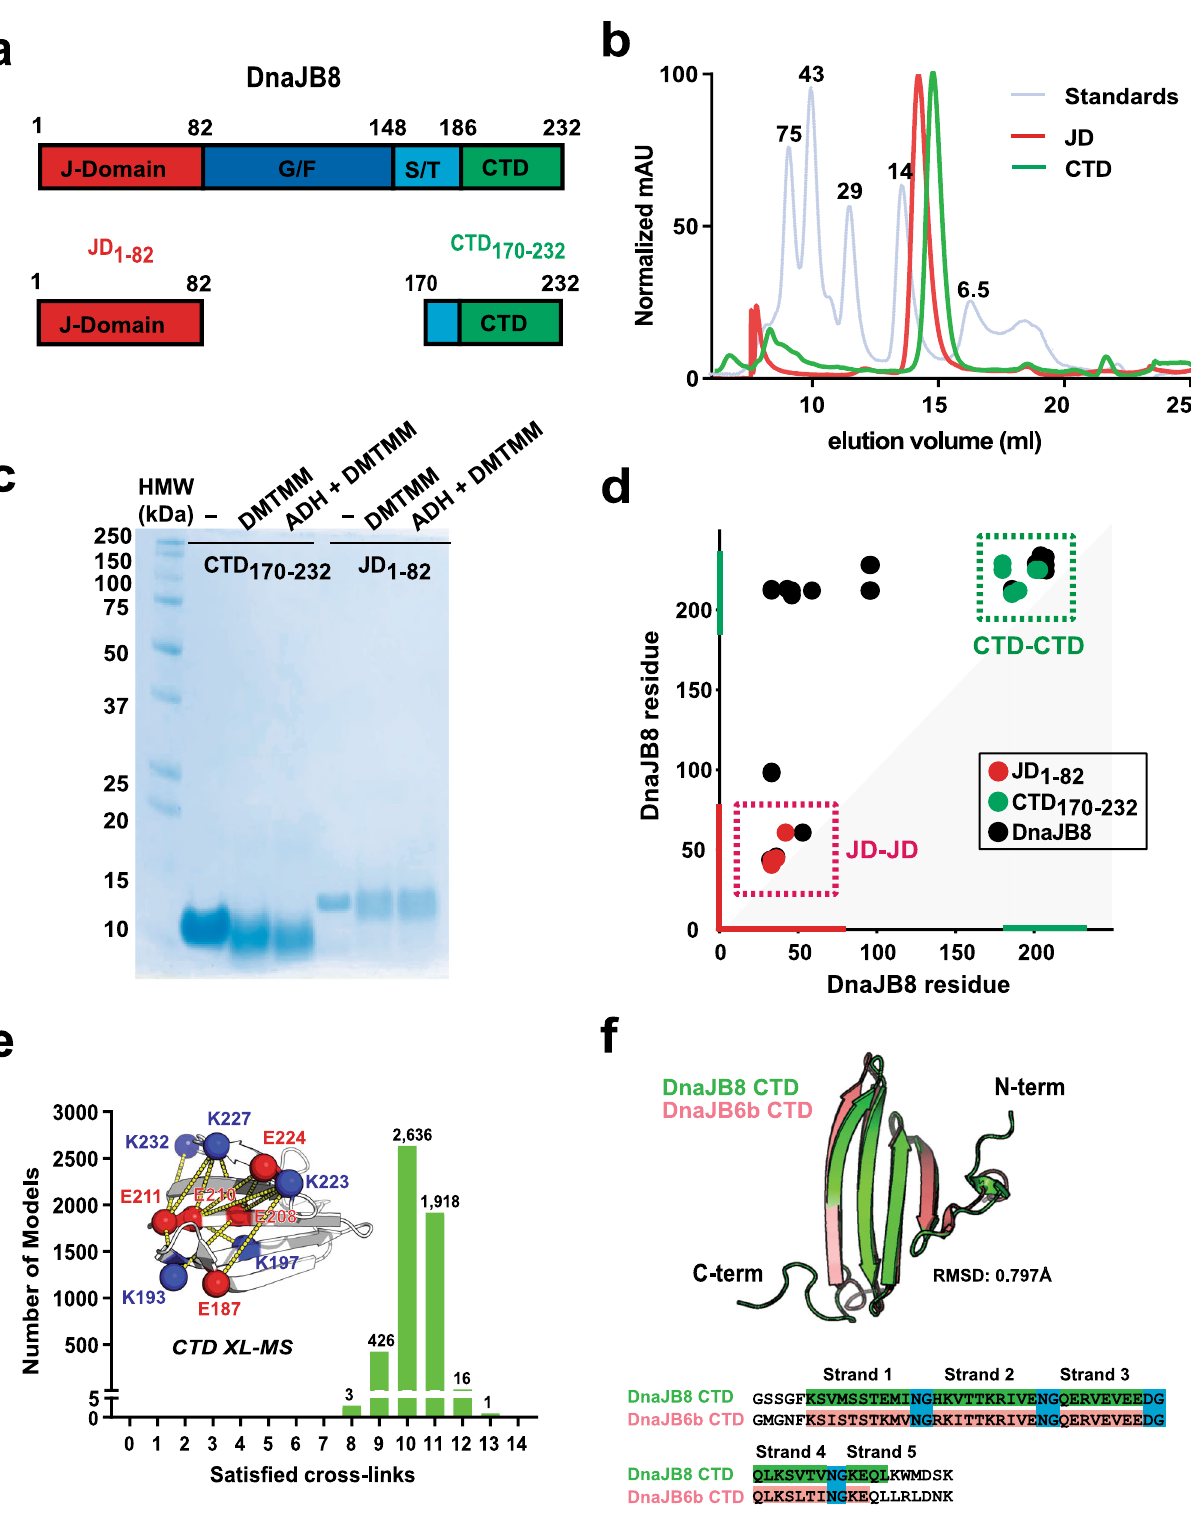
DnaJB8 oligomers. Solution NMR-based chemical shift pertur- bation mapping was used to identify the JD 1 – 82 surface that interacts with the CTD 170 – 232 (Fig. 5 and Supplementary Fig. 5b, c). Titration of increasing amounts of unlabeled CTD 170 – 232 into 50 μ M 15 N-labeled JD 1 – 82 produced fast-exchanging concentra- tion-dependent chemical shift perturbations in a speci fi c subset of peaks (Fig. 5d, e); 17 peaks were perturbed (>0.005 p.p.m.).